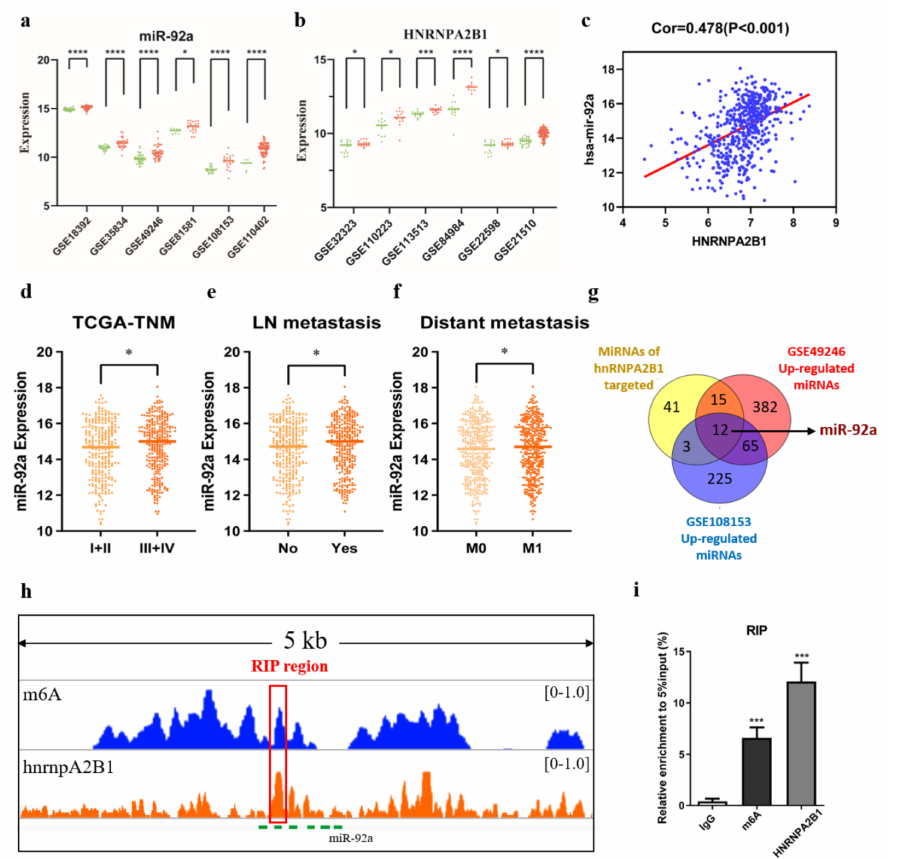
Figure 4. HNRNPA2B1 may regulate miR-92a expression through m6A modification. ( a , b ) Higher miR-92a and higher HNRNPA2B1 expression in a series of GEO datasets; ( c ) positive correlations between HNRNPA2B1 and miR-92a; ( d – f ) the relationship between miR-92a expression and clinical characteristics of TNM stage, lymph node metastasis, and distant metastasis, respectively; ( g ) the Venn diagram of HNRNPA2B1-targeted miR-92a from the GEO datasets (GSE108153, GSE49246) and Lee’s study; ( h ) the enrichment peak of m6A and HNRNPA2B1 in miR-92a sites from the HITS CLIP sequence; ( i ) RIP-qPCR showed that the m6A and HNRNPA2B1 peak region was occupied by the nearby miR-92a sites in SW480 cells. * p < 0.05; *** p < 0.001; **** p <